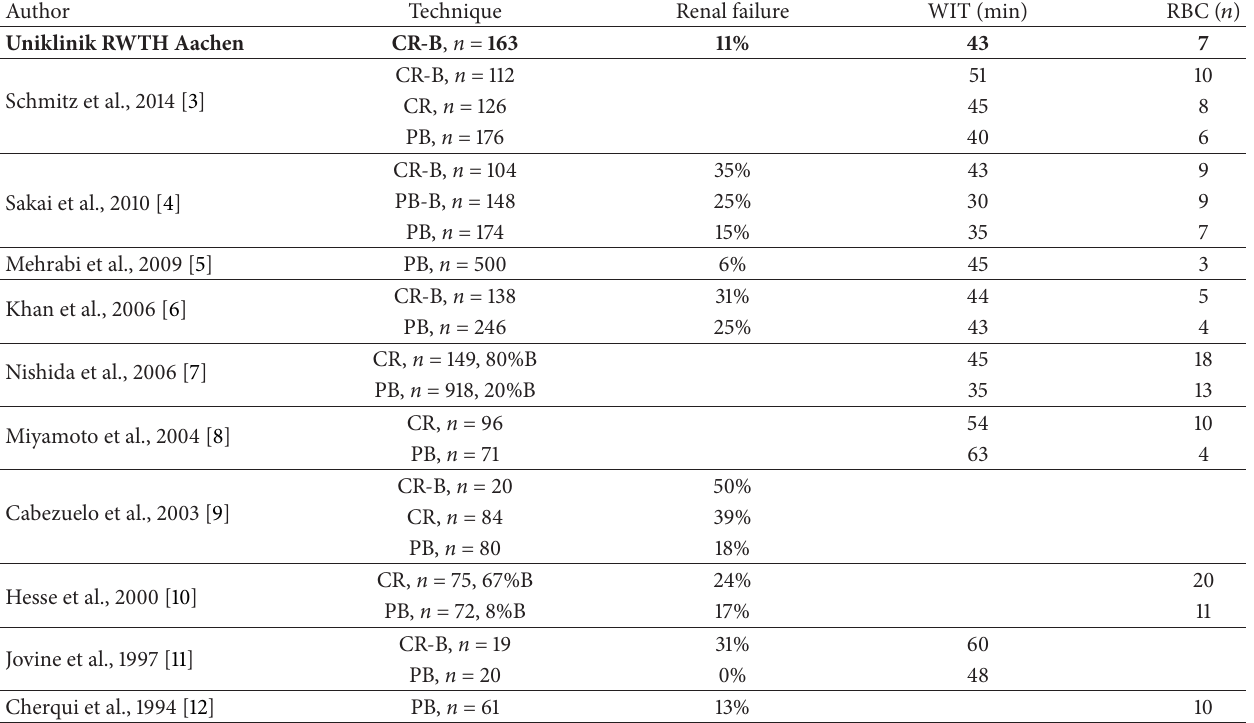
Table 5: Summary of current literature with comparison to our